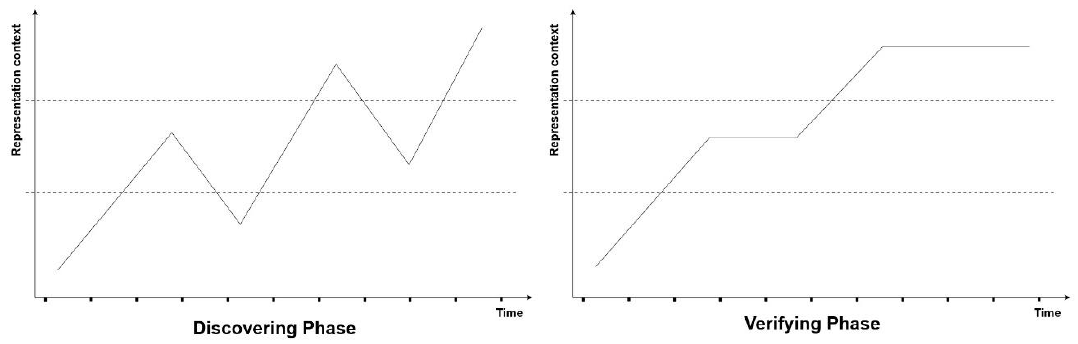
Figure 3. Backward reasoning behavior in discovering and verifying phases.